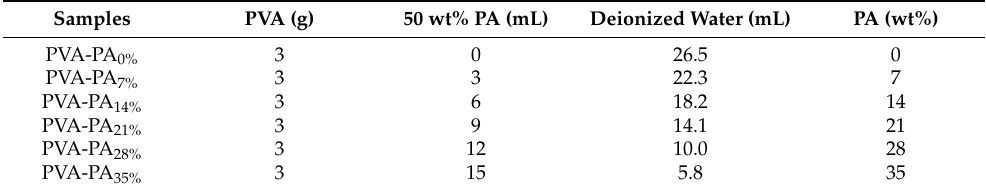
Table 1. The amount of different components added into PVA-PA X gel